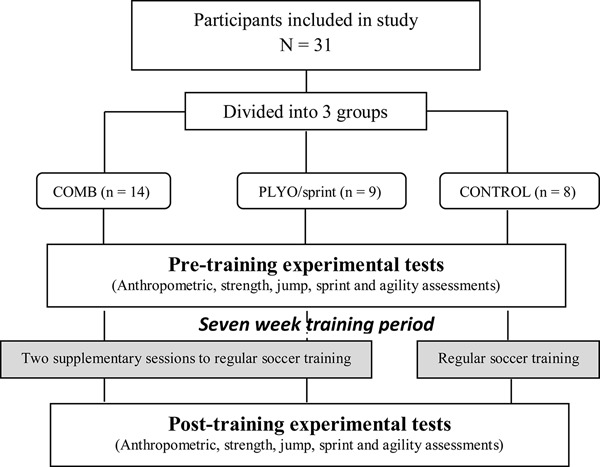
Experimental design. COMB: combination of 1 plyometric/sprint and 1 traditional resistance training sessions per week. Plyo/sprint: addition of 2 plyometric and sprint training sessions per week.